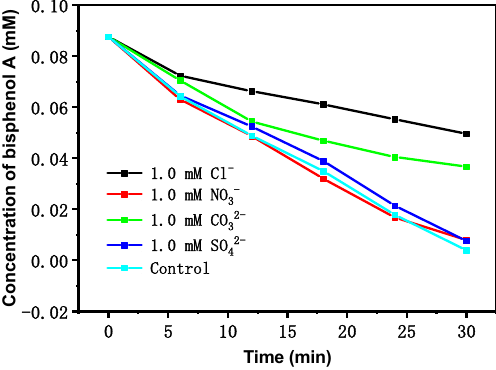
Figure 7. The effect of different concentration of Ag 3 PO 4 on the photocatalytic removal efficiency of bisphenol A with Ag 3 PO 4 as a photocatalyst under visible light irradiation.